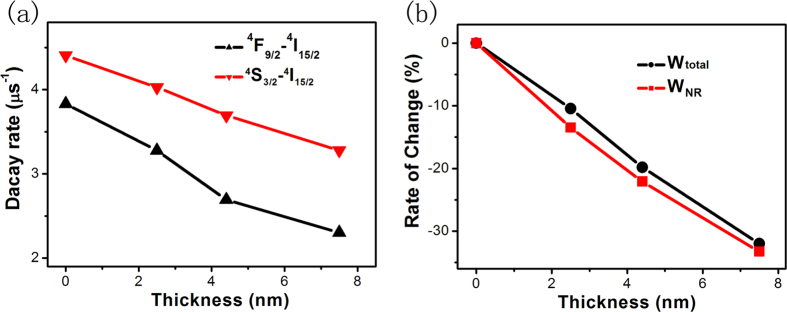
(a) Decay rate of 4S3/2-4I15/2 and 4F9/2-4I15/2 as a function of the intermediate NaYF4 thickness. (b) Variation of calculated nonradiative relaxation rate (WNR, 4F7/2-2H11/2/4S3/2) and the total decay rate (Wtotal, 4S3/2-4I15/2) as a function of the intermediate spacer thickness.